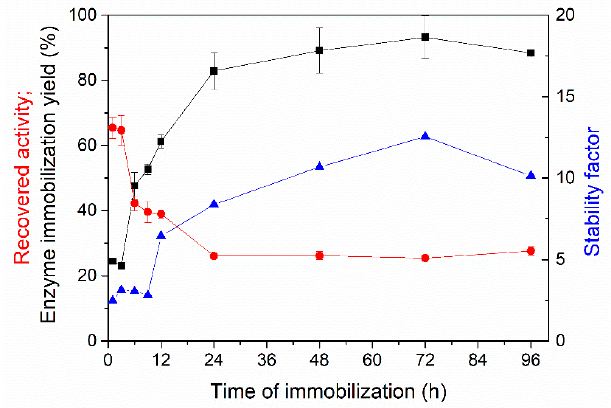
Figure 3. Enzyme immobilization yield ( ■ ), recovered activity ( ● ) and stability factor at 50 °C and pH 8.0 ( ▲ ) for different immobilization times (20 °C, pH 10.0, protein load 4.6 mg/g support) of NPD